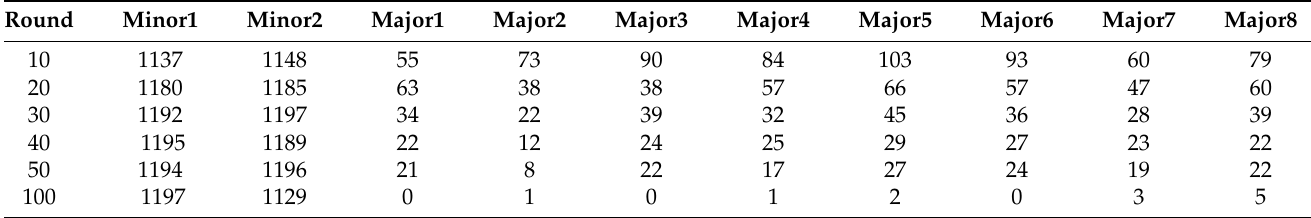
Table 2. Forgettable example counts in each client when non-IID (2-to-8).